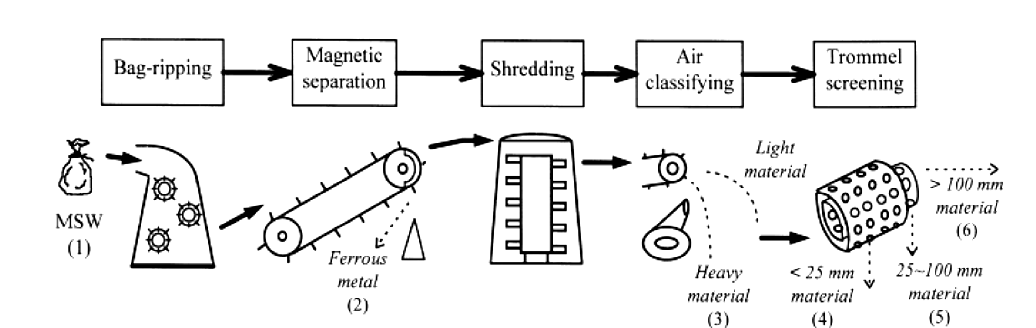
Figure 1 . System configuration of the solid waste presorting process (Chang et al.